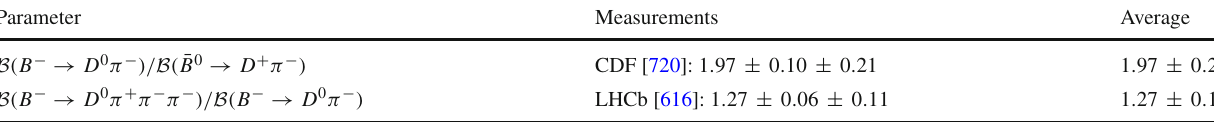
Table 138 Relative decay rates to D 0 mesons I Parameter